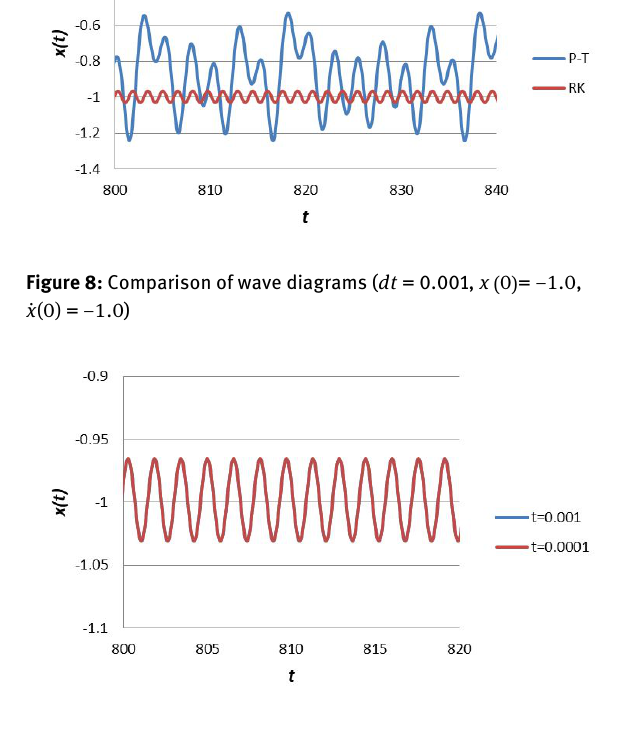
Figure 9: Wave diagram under different time step for RK method ( dt = −1.0 , ˙ x (0) = −1.0